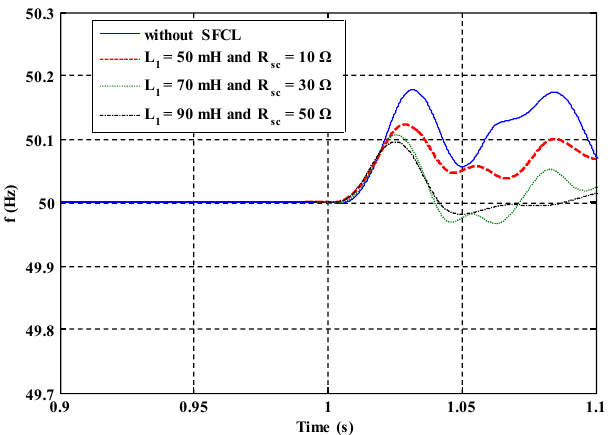
Figure 13. Frequency fluctuations of the micro ‐ grid under the external fault.